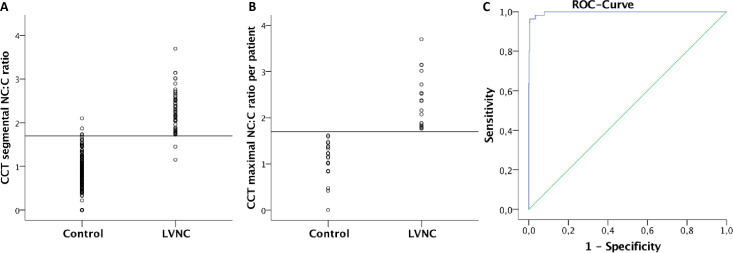
CCT NC:C ratio per patient and per segment.Using the NC:C threshold of ≥1.8 (horizontal line), CCT identified 55 LVNC segments in 17 patients. 3 segments were false positive, and 2 segments were false negative (A). Using this cut-off, all LVNC patients could be identified (B). ROC analysis of the quantitative segmental NC:C CCT analysis revealed an area under the curve of 0.997 (C).